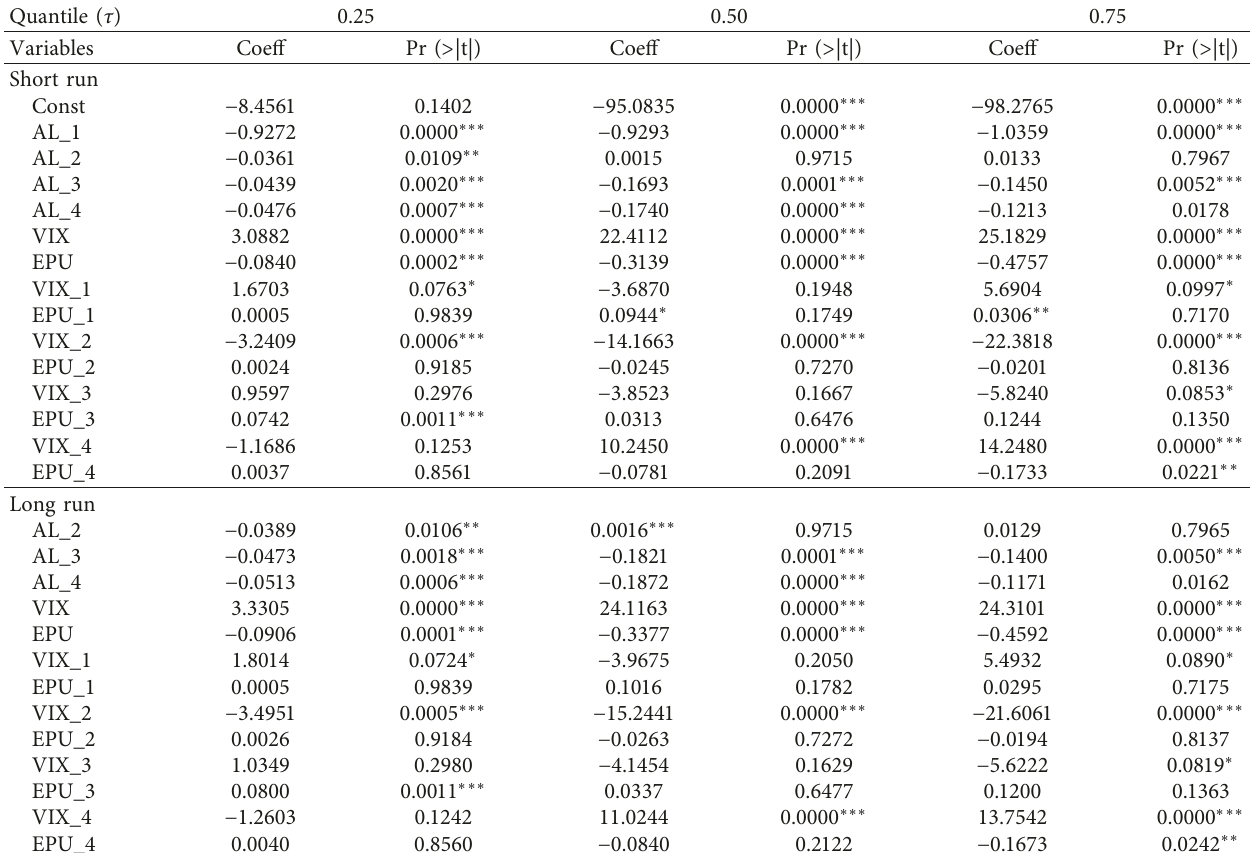
Table 12: QARDL estimation results: pandemic period (independent variables: EPU and VIX).